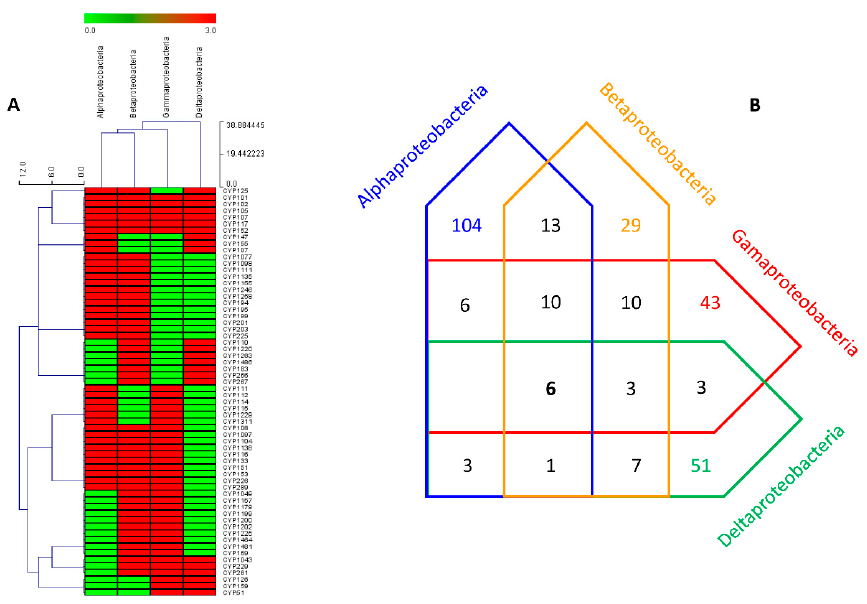
Figure 3. P450 family conservation analysis in proteobacterial species belonging to four different classes. ( A ) The heat map represents the presence (red) or absence (green) of the P450 family in proteobacterial species. P450 families form the vertical axis, and four different proteobacterial classes form the horizontal axis. ( B ) A Venn diagram represents the number of P450 families that are unique and commonly present among proteobacterial species belonging to four different classes. The numbers indicate the number of P450 families. The number of P450 families conserved among four proteobacterial classes is indicated in bold. A detailed analysis of the families, subfamilies, and member count is presented in Table